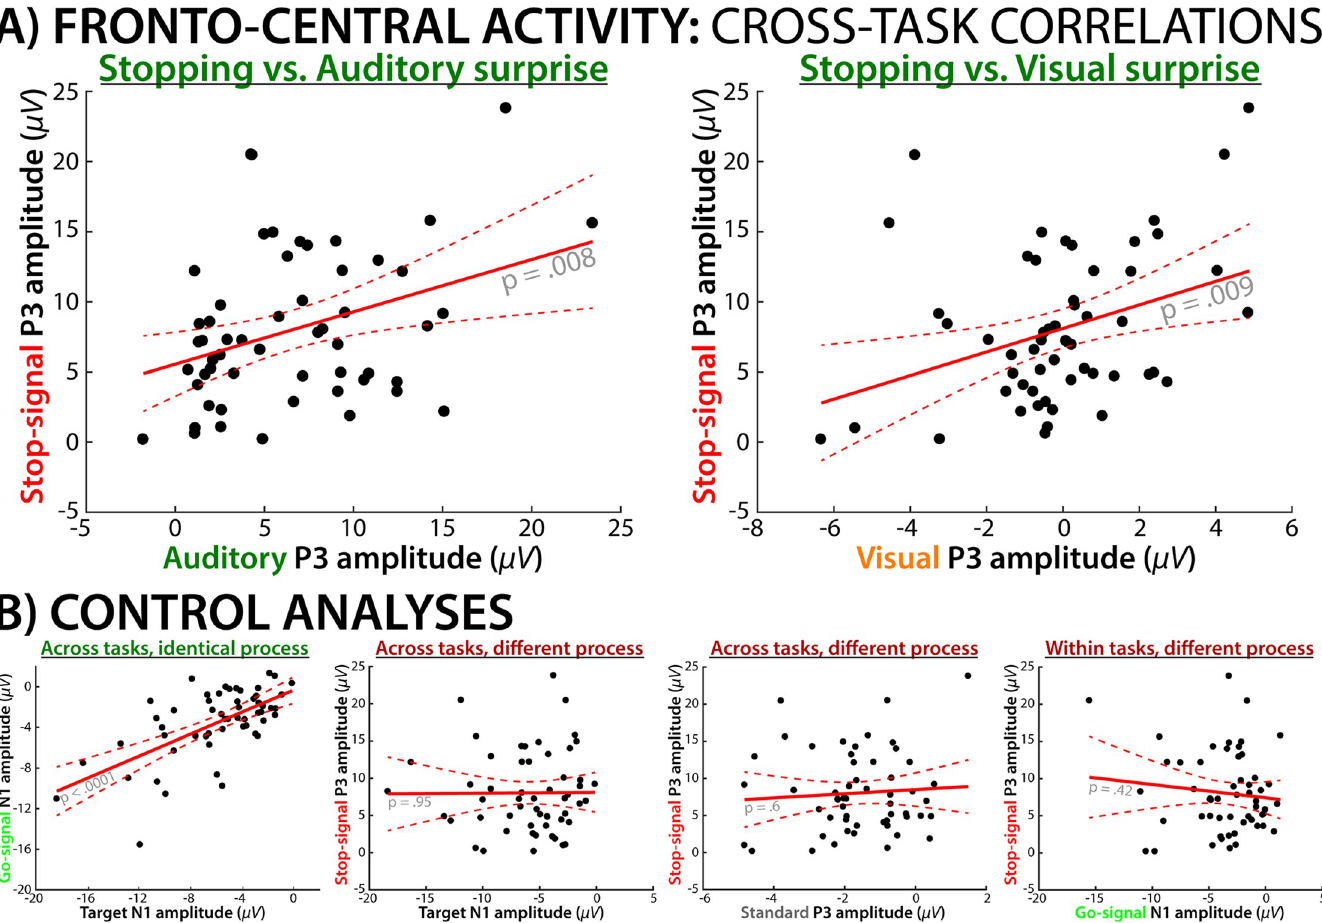
Fig 7. Cross-task correlations between fronto-central activity during surprise processing and action-stopping. A) The amplitude of the stop-signal P3 in the SST was positively correlated with the surprise-related P3 in the CMO task; this was the case for both for auditory (left) and visual (right) unexpected cues. B) Control analyses show that ERP amplitudes of similar processes are indeed positively correlated across tasks (illustrated by the posterior visual N1 to the imperative arrow stimuli in both tasks–i.e., the Go-signal in the SST and the target in the CMO task). Ruling out alternative explanations, there was no reliable correlation for different waveforms from different tasks (middle left; Target visual N1 to stop-signal P3), different waveforms from the same task (right; go-signal visual N1 to stop-signal P3), or the same waveform from different tasks (middle right; standard cue P3 to stop-signal P3). These control analyses demonstrate that there is no general relationship between ERP amplitudes within or across the same task or within the same region of cortex, unless related processes are